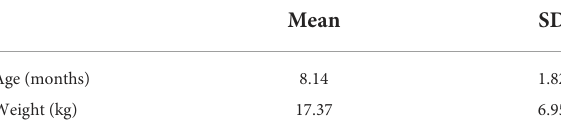
TABLE 3 Frequencies for sex, treated limb, and